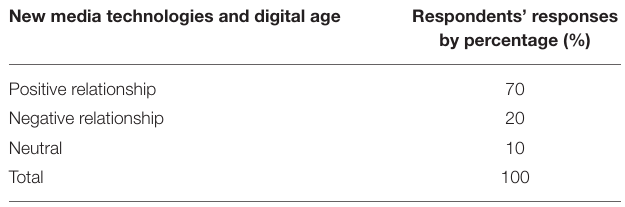
TABLE 3 | Concept of new media technology.